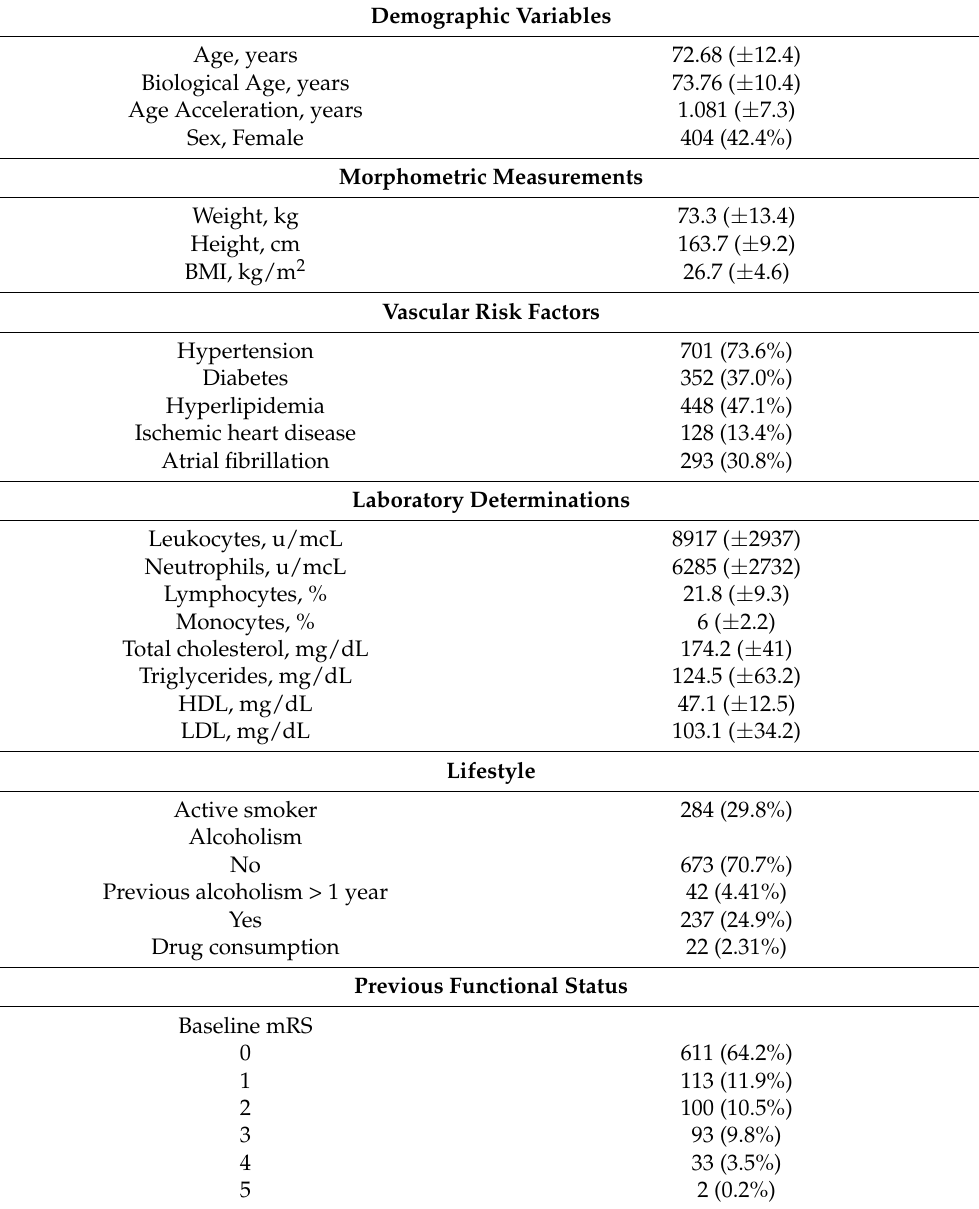
Table 1. Main characteristics from the study sample (N =